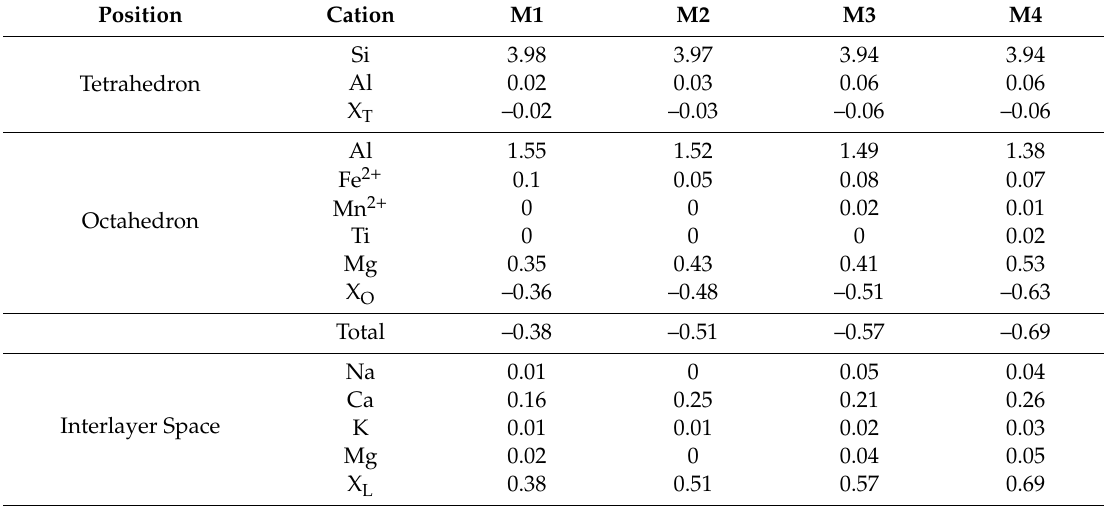
Table 2. Calculation results of layer charge density of four kinds of